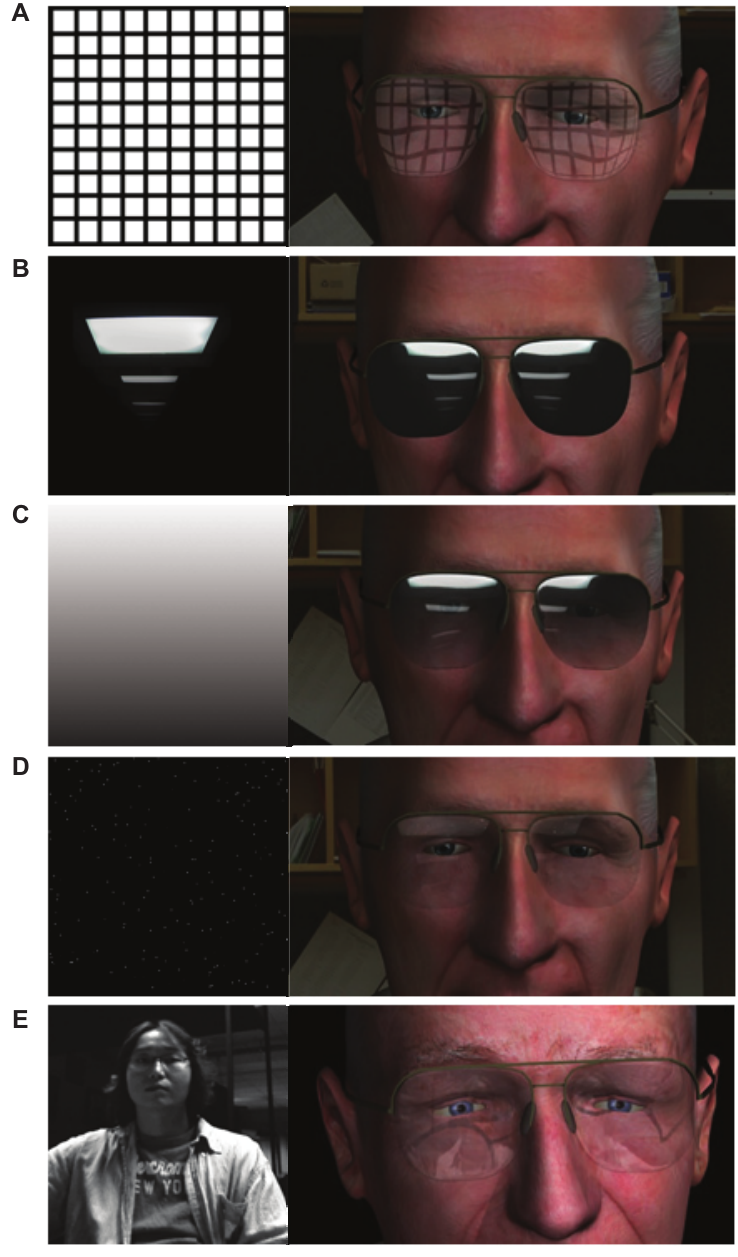
Figure 23. Iterative Design of Reflective Material Rendering